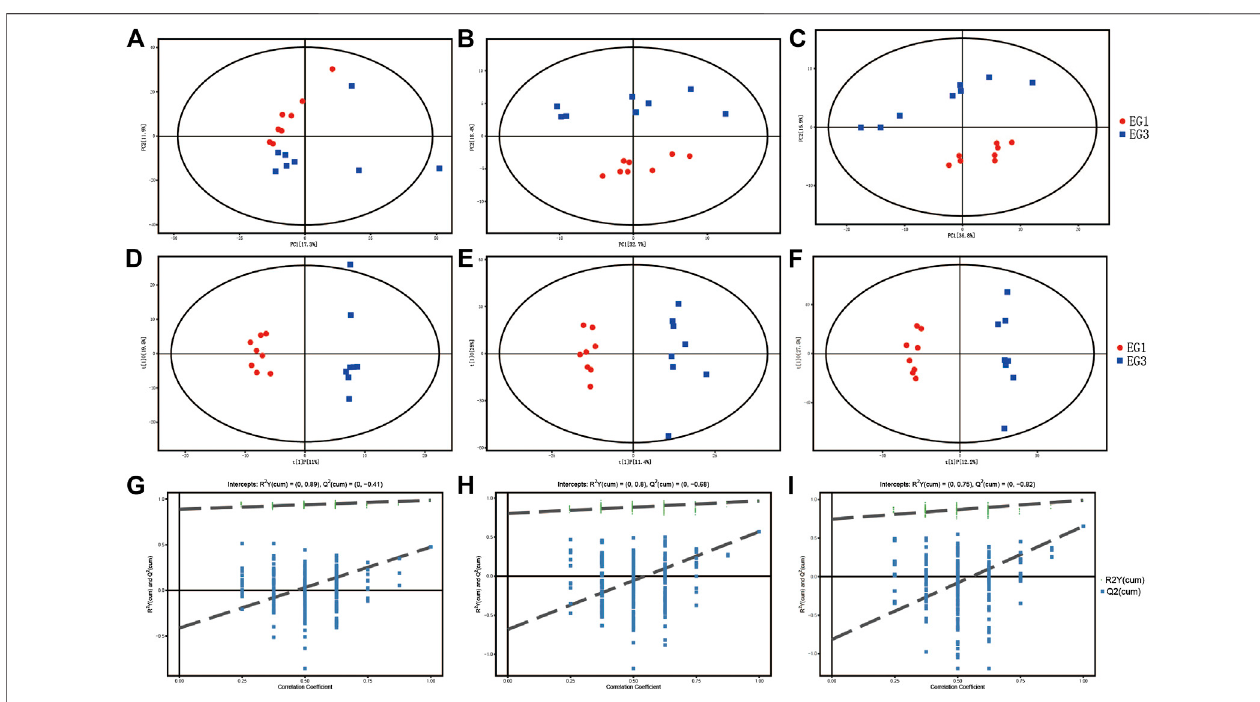
FIGURE 1 | PCA model score scatter plot, OPLS-DA model, and permutation test for EG1 and EG3. The PCA model (A – C) , OPLS-DA model (D – F) , and permutation test of the OPLS-DA model (G – I) were derived from metabolomics pro fi les. A, D, and G were derived from the GC – MS; B, E, and H were derived from the LC – MS POS ion mode; and C, F, and I were derived from the LC – MS NEG ion